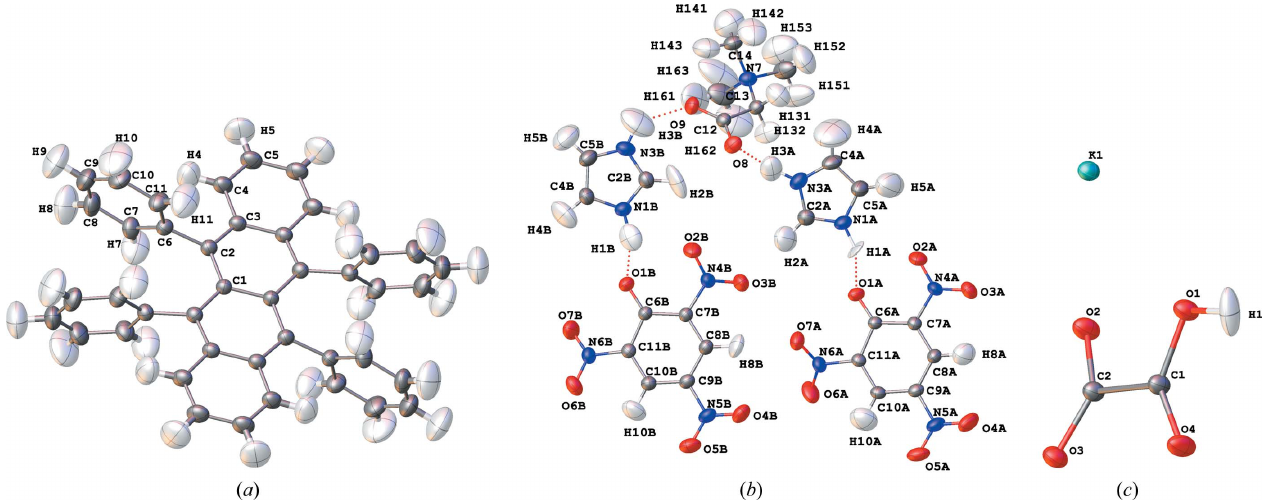
Figure 2 Molecular structures and anisotropic displacement parameters (90% probability surfaces) for ( a ) rubrene, ( b ) BIPa and ( c ) KHOx, obtained from HAR and plotted with Olex2 (HF/def2-TZVP, with point charges and dipoles simulating the crystalline environment for rubrene and BIPa, or an explicit cluster of neighbouring molecules for KHOx). Corresponding representations based on the neutron data are shown in Fig. S3 in the supporting